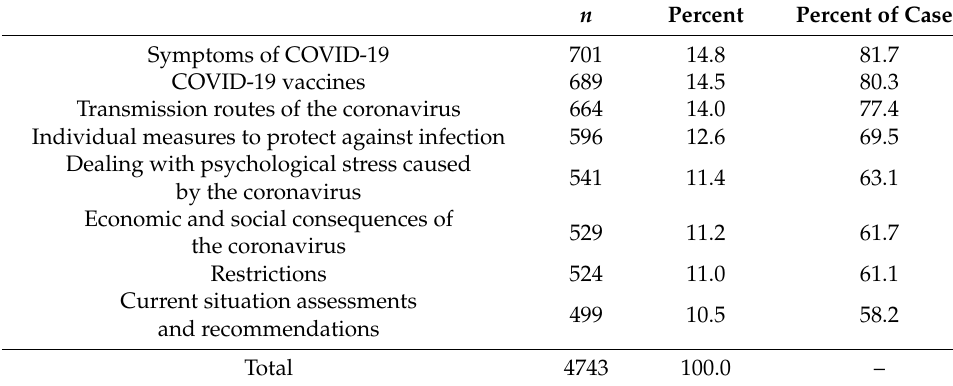
Table 4. Thematic areas university students searched during the COVID-19 period.